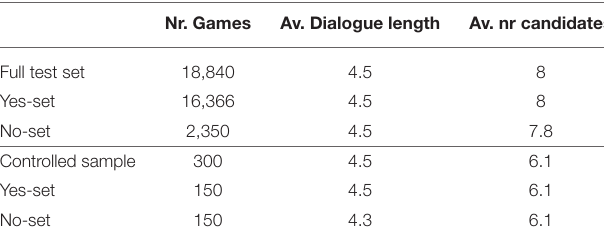
TABLE 1 | Statistics on the full test set and on the Controlled test set; both divided into the Yes- (resp. No-) subsets obtained by selecting only dialogues with a positively (resp. negatively) answered question in the last